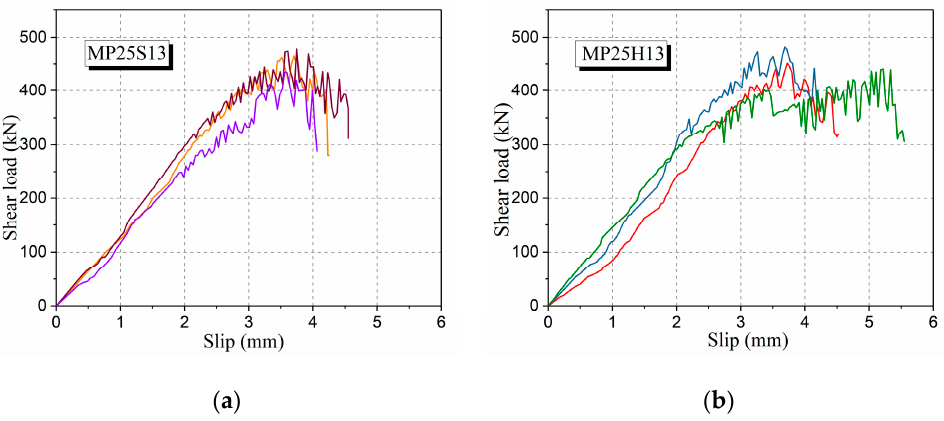
Figure 12. Shear load–slip curves of UHPC specimens with different fiber types: ( a ) MP25S13 and ( b ) MP25H13.